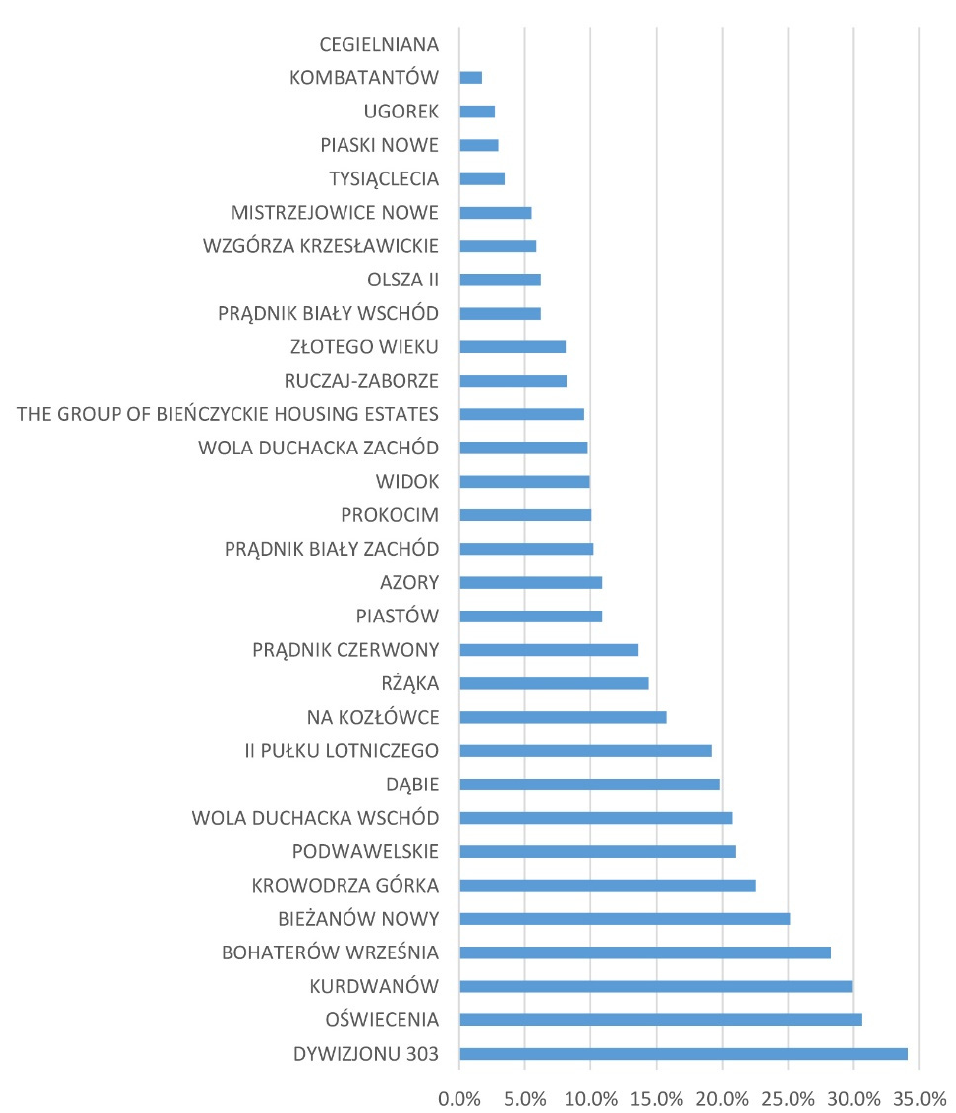
Figure 3. Diagram illustrating a relative development increase in large-panel housing estates in Cracow. An analysis of the increase in the built-up area demonstrates that densifying housing estates with new buildings is more intensive in the southern part of the city, and on average, it reaches 18.2%. The average increase in built-up areas in the northern housing estates is 13.8%. The total average for all the housing estates is 15.4%. The biggest number of housing estates—14—increased their built-up area within the range of 1 to 10%. Eight housing estates were in the range 10–20%. In six housing estates, the increase is at the level of over 30%. The housing estates that stand out due to the largest increase in the built-up area, i.e., 30% or more, are Kurdwan ó w, Dywizjonu 303, and O´swiecenia housing estates.